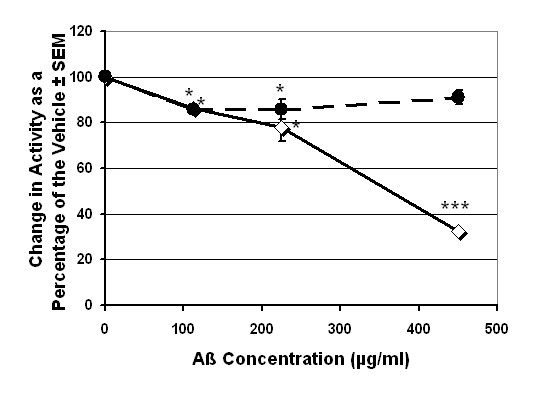
Amyloid-beta 1–42 peptide inhibits Na+/K+ ATPase activity. Purified cerebral Na+/K+ ATPase was pre-incubated with vehicle or Aβ 1–42, and enzyme activity percentages of the vehicle (20 μmols Pi/mg protein/hour) are presented (mean ± SEM). "◊" indicates the values for the soluble (DMSO+water) Aβ suspension. "○" indicates the values for the fibrillar (DMSO+neutralized HCl) Aβ suspension. At the highest concentrations, the soluble preparation dramatically reduces Na+/K+ ATPase activity compared to both vehicle and the fibrillar Aβ preparation. * (p < 0.05) and *** (p < 0.001) indicates significant differences between Aβ and vehicle alone when measured by one-way ANOVA.